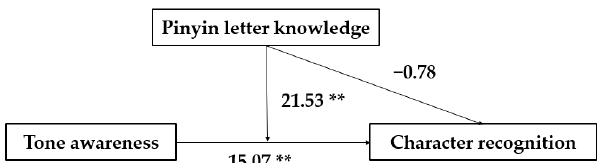
Figure 1. Moderation model of Chinese tone awareness, Pinyin letter knowledge, and character recognition. Note, ** p < 0.01.